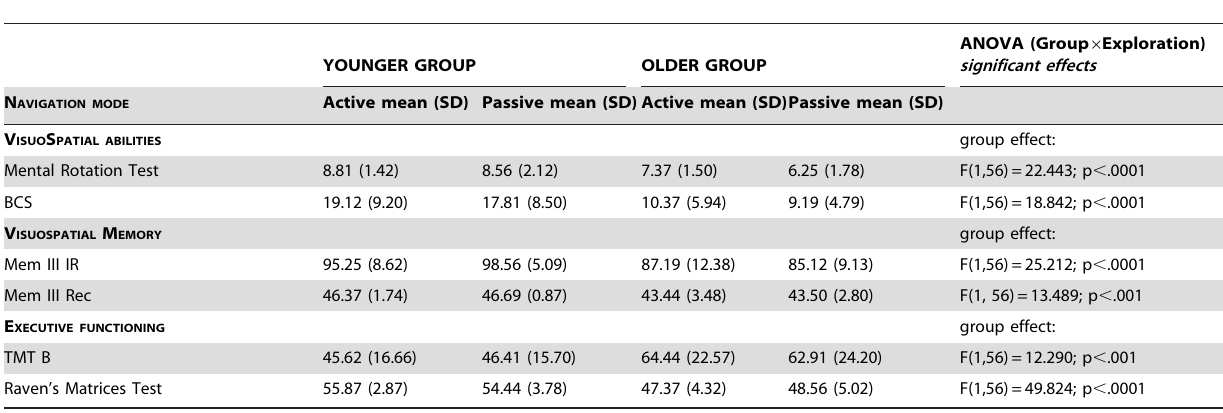
Table 2. Participant’s scores on the neuropsychological assessments and the ANOVA (Group x Exploration) results.